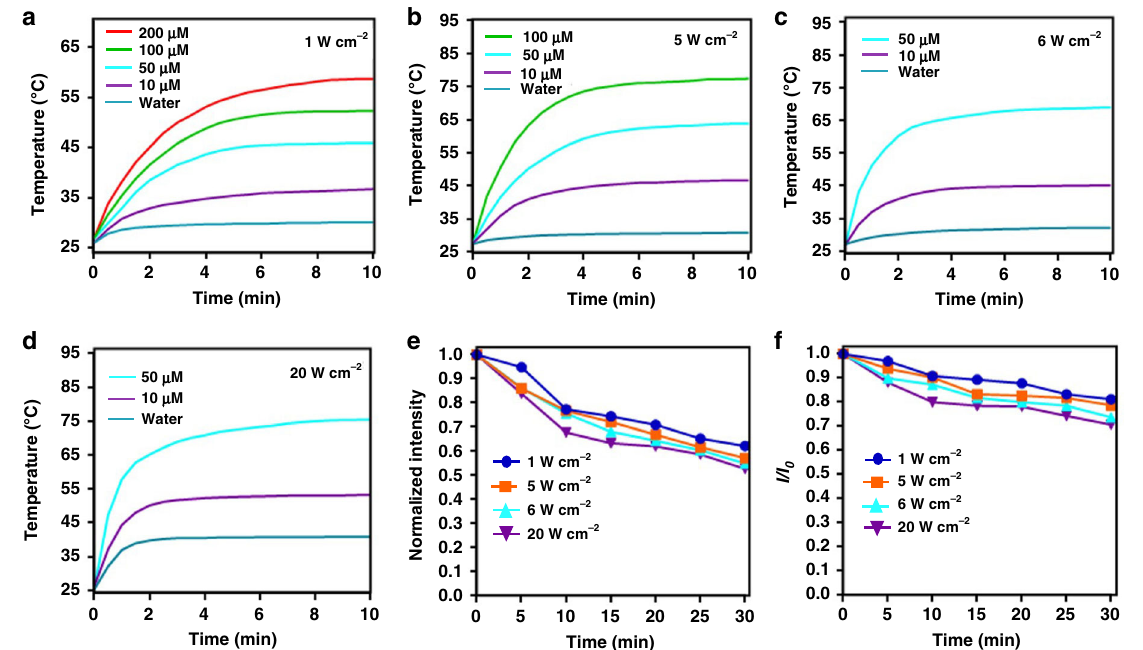
Fig. 5 Photothermal conversion behaviors and photostability of BPBBT NPs. a – d Photothermal effect of BPBBT NPs at different concentrations under an 808-nm light irradiation with different power densities. e Normalized fl uorescence intensity of BPBBT NPs solutions (50 µ M of BPBBT) at the maximum emission wavelength over time following an 808-nm laser irradiation with different power densities. f Plot of I/I 0 versus the irradiation time. I 0 and I are the maximal NIR absorbance of BPBBT NPs solutions (50 µ M of BPBBT) before (0 min) and after laser irradiation,